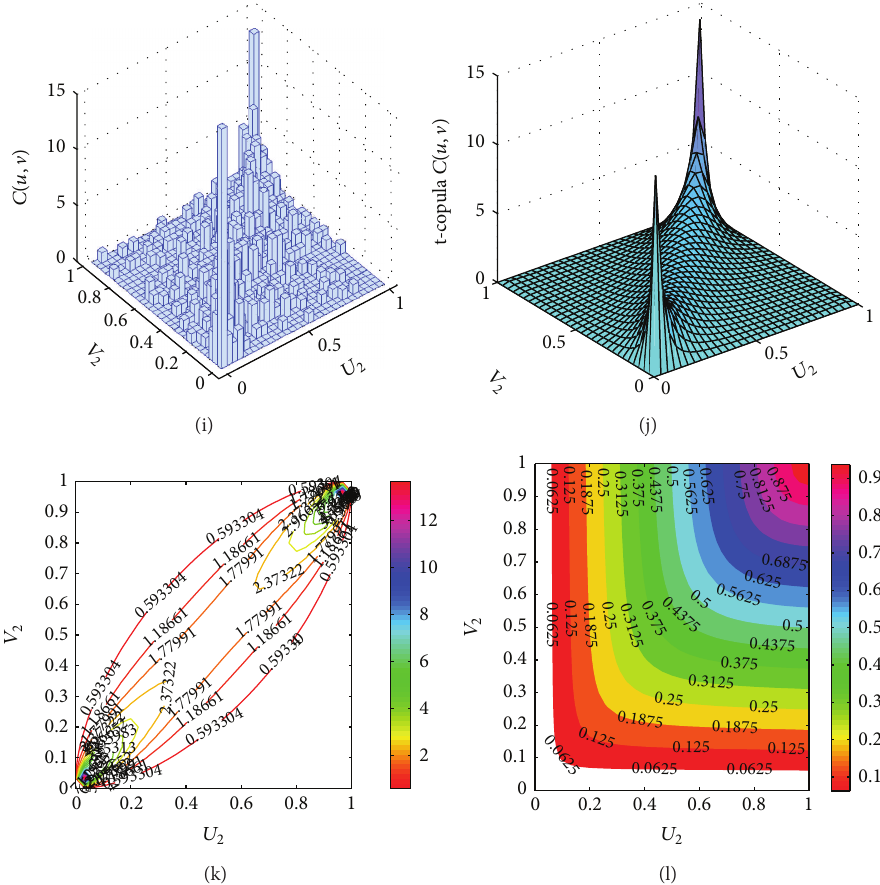
Figure 2: Plots of SSE and SZSE indexes by t-copula. (a) Frequency histogram; (b) density function diagram; (c) contour of joint density functions; (d) contour of distribution functions. Plots of the model with S.data1 ( 𝜆 = 2 and 𝜆 = 2.5 ) by t-copula. (e) Frequency histogram; (f) density function diagram; (g) contour of joint density functions; (h) contour of distribution functions. Plots of the model with S.data1 ( 𝜆 = 3 and 𝜆 = 2.5 ) by t-copula. (i) Frequency histogram; (j) density function diagram; (k) contour of joint density functions; (l) contour of distribution